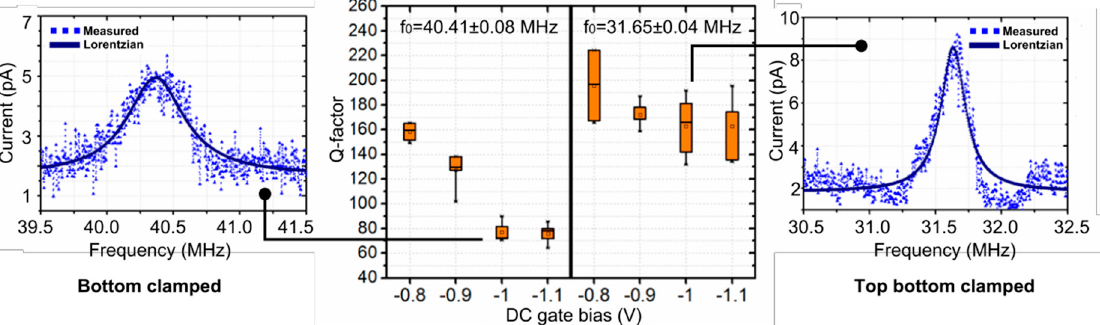
Figure 3. Q-factor ( middle ) extracted from Lorentzian curve fit ( left, right ) at different DC gate bias for bottom clamped (left) and top-bottom clamped ( right ). The resonance frequency did not change significantly. Each box represents Q-factors obtained from five measured spectral responses measured at V gac = 18 mV, V sdac = V sdDC = 10